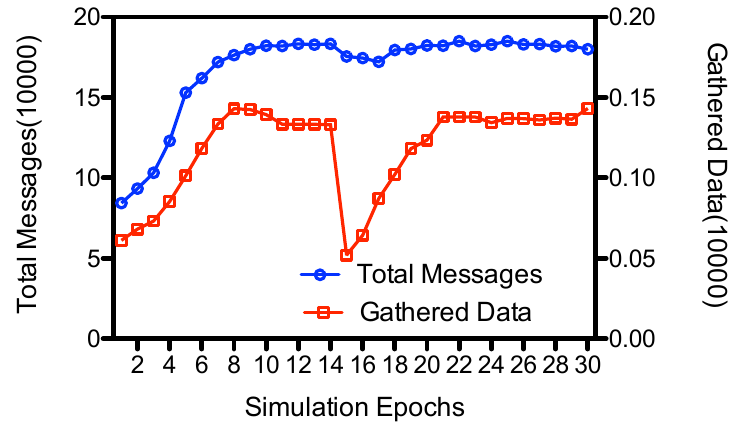
Figure 12. Message transmissions at each